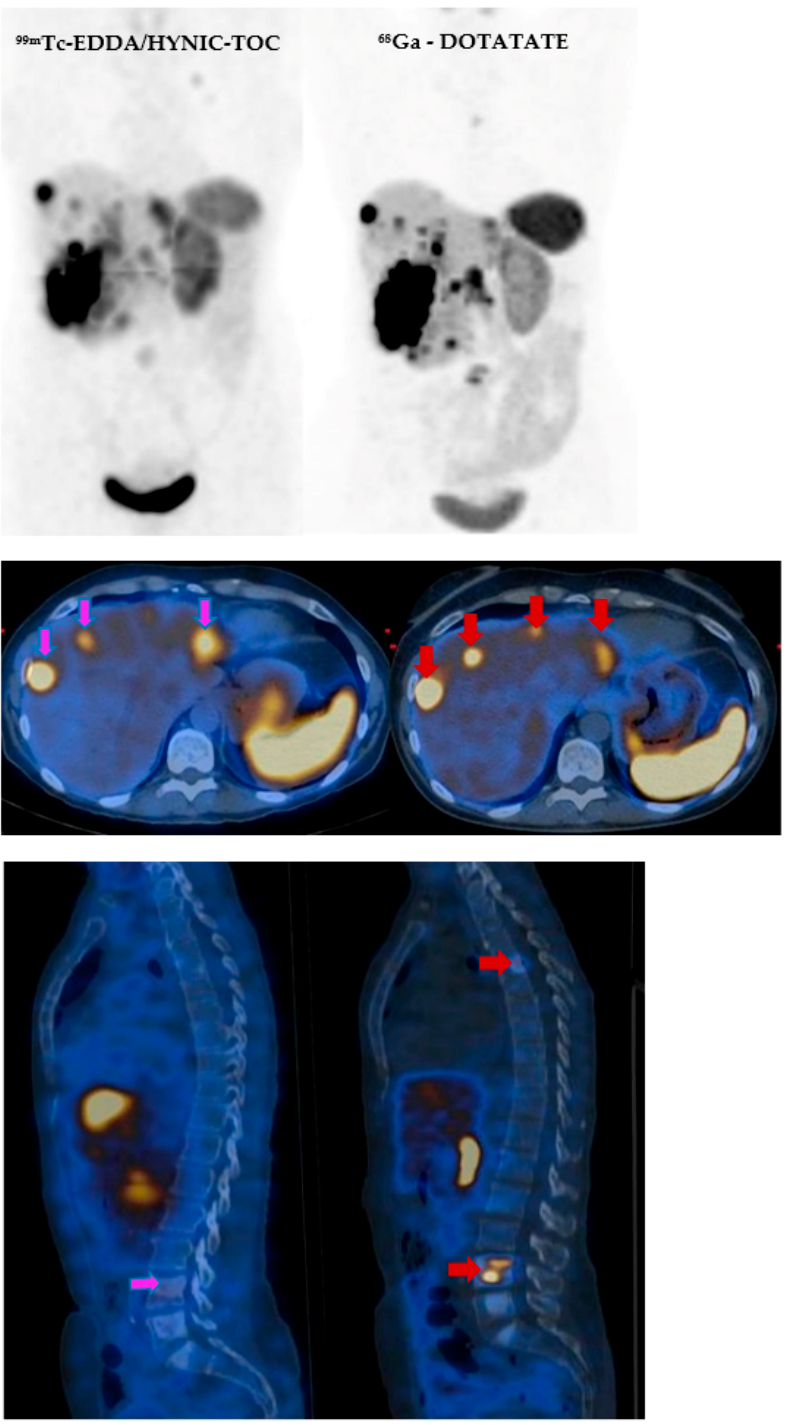
Figure 5. Comparison between 99m Tc-EDDA/HYNIC-TOC SPECT/CT (pink arrows) and 68 Ga-DOTATATE PET/CT (red arrows) in a 54-year-old female patient, diagnosed with a pancreatic neuroendocrine tumor (G2), with multiple liver, lymphatic, and osseous metastases. The patient underwent four sessions of 177 Lu-DOTATATE PRRT between the PET scan and the SPECT examination. A better resolution for the 68 Ga-DOTATATE study can be observed, highlighting its higher capacity to detect smaller hepatic lesions and bone metastases. However, similar results can be seen both on 99m Tc-EDDA/HYNIC-TOC SPECT/CT and 68 Ga-DOTATATE PET/CT for bigger